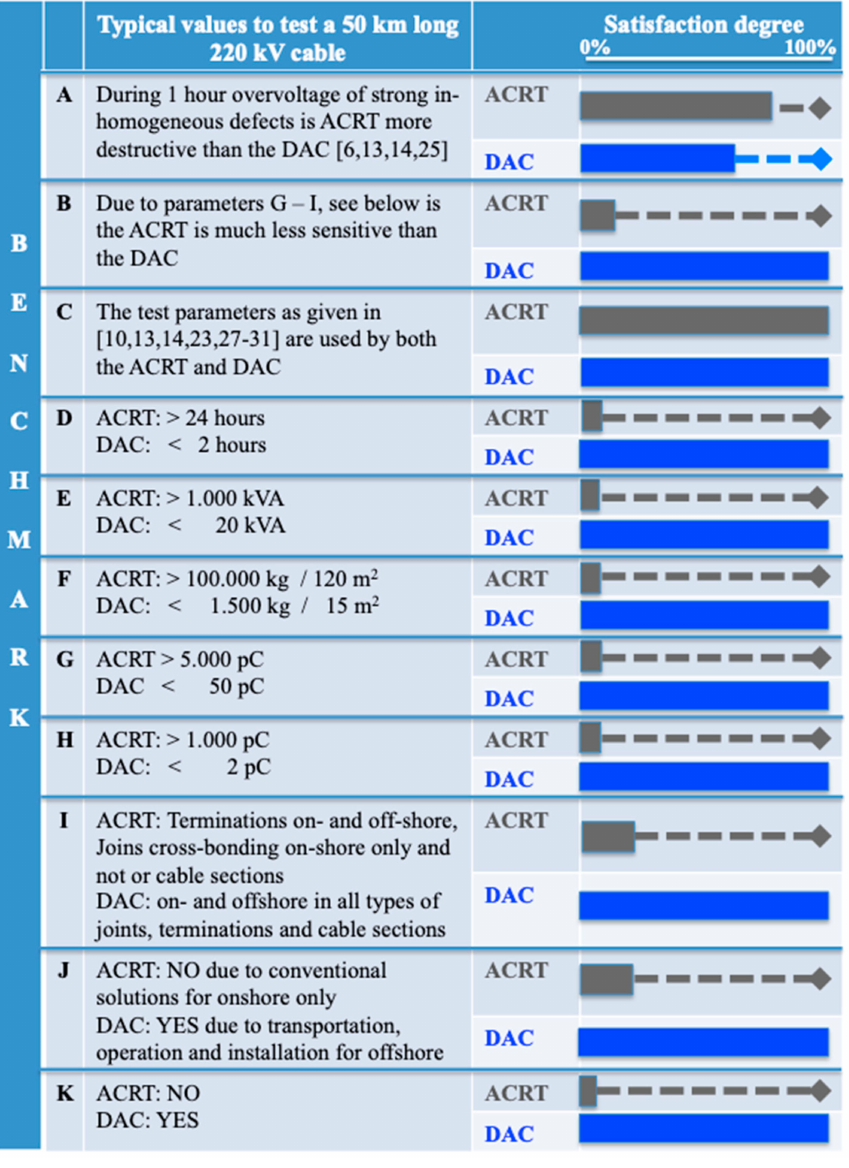
Figure 3. Example of a comparison of ACRT and DAC testing techniques based on different technical and practical parameters for testing a 50 km long 220 kV cable